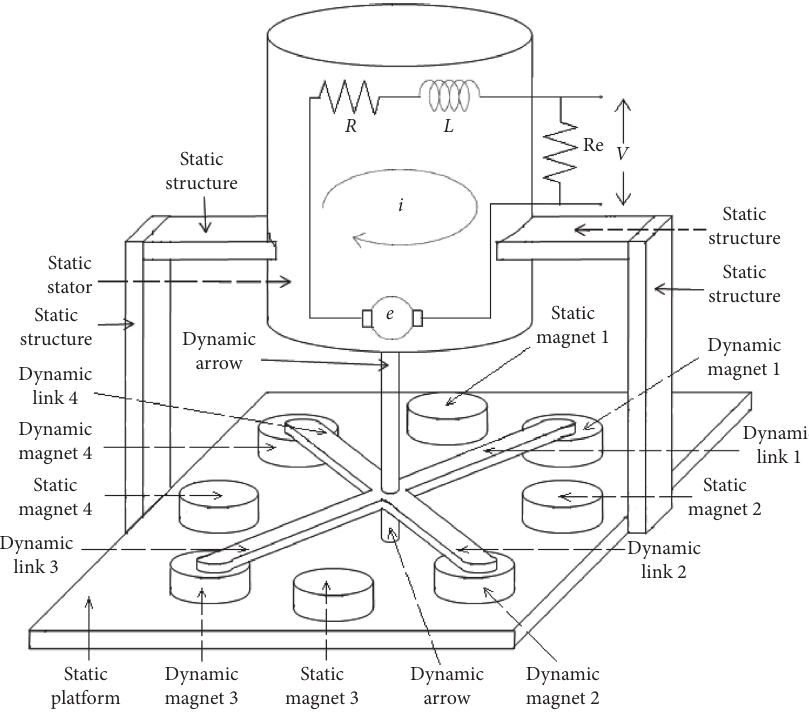
Figure 1: Electricity generator with static magnets and dynamic